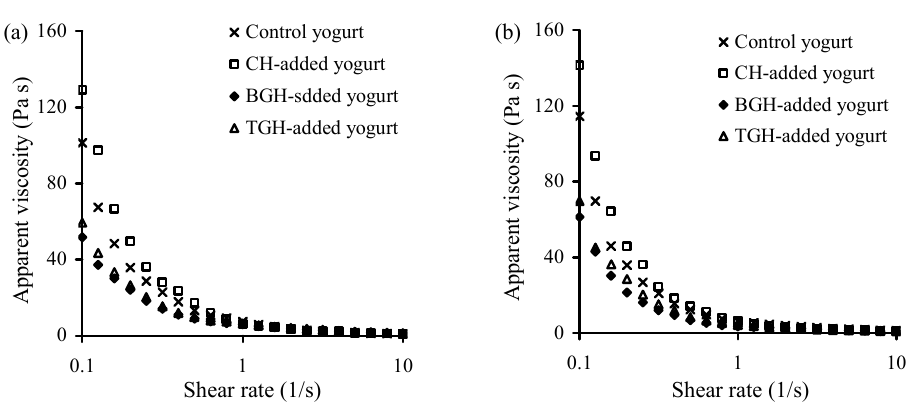
Figure 1. Apparent viscosity of the four yogurt samples stored at 4 ° C for 1 ( a ) or 21 days ( b ).